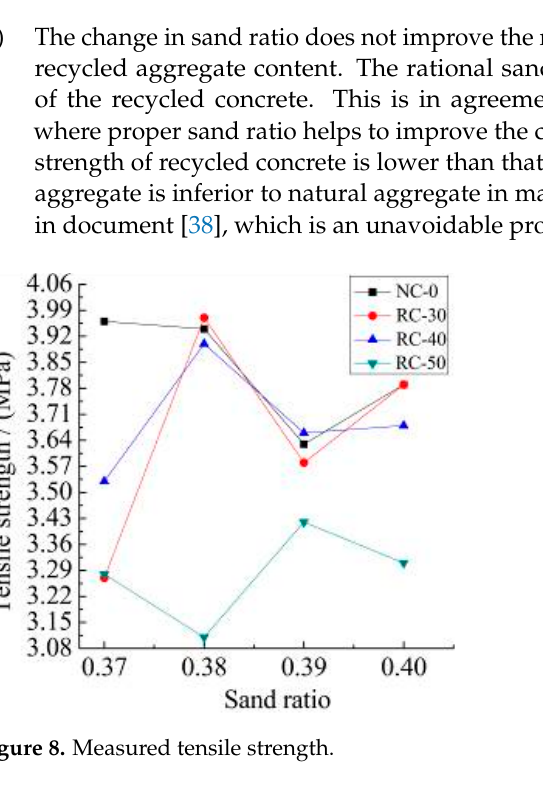
Figure 10. Tension and compression ratio.